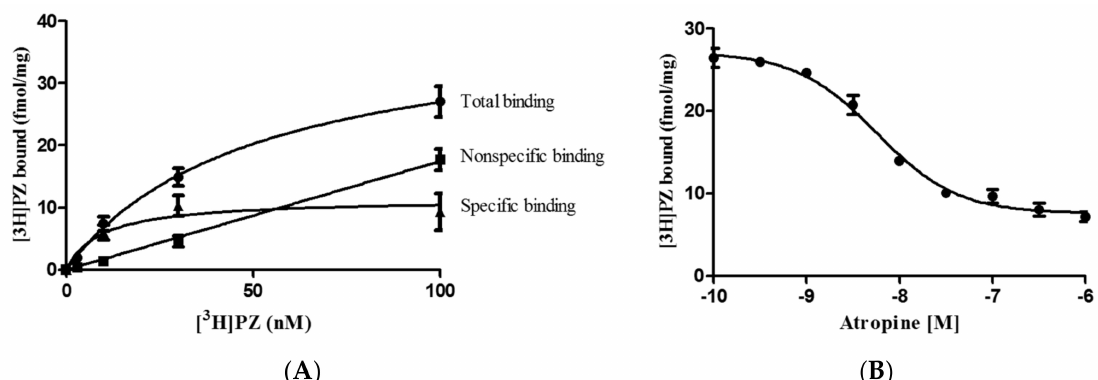
Figure 1. ( A ) Total, nonspecific and specific binding of [ 3 H] pirenzepine ([ 3 H]PZ) to muscarinic acetylcholine receptors (AChRs) in the rat brain homogenate. For the nonspecific binding, 10 − 6 M atropine was added to displace [ 3 H]PZ from the AChRs. The K P of [ 3 H]PZ found was 9.3 × 10 − 9 M; ( B ) Displacement of [ 3 H]PZ (30 nM) to muscarinic AChRs by atropine. The K D of atropine found was 1.4 × 10 − 9 M. Data are shown as mean ± standard error of the mean (S.E.M.) ( n =